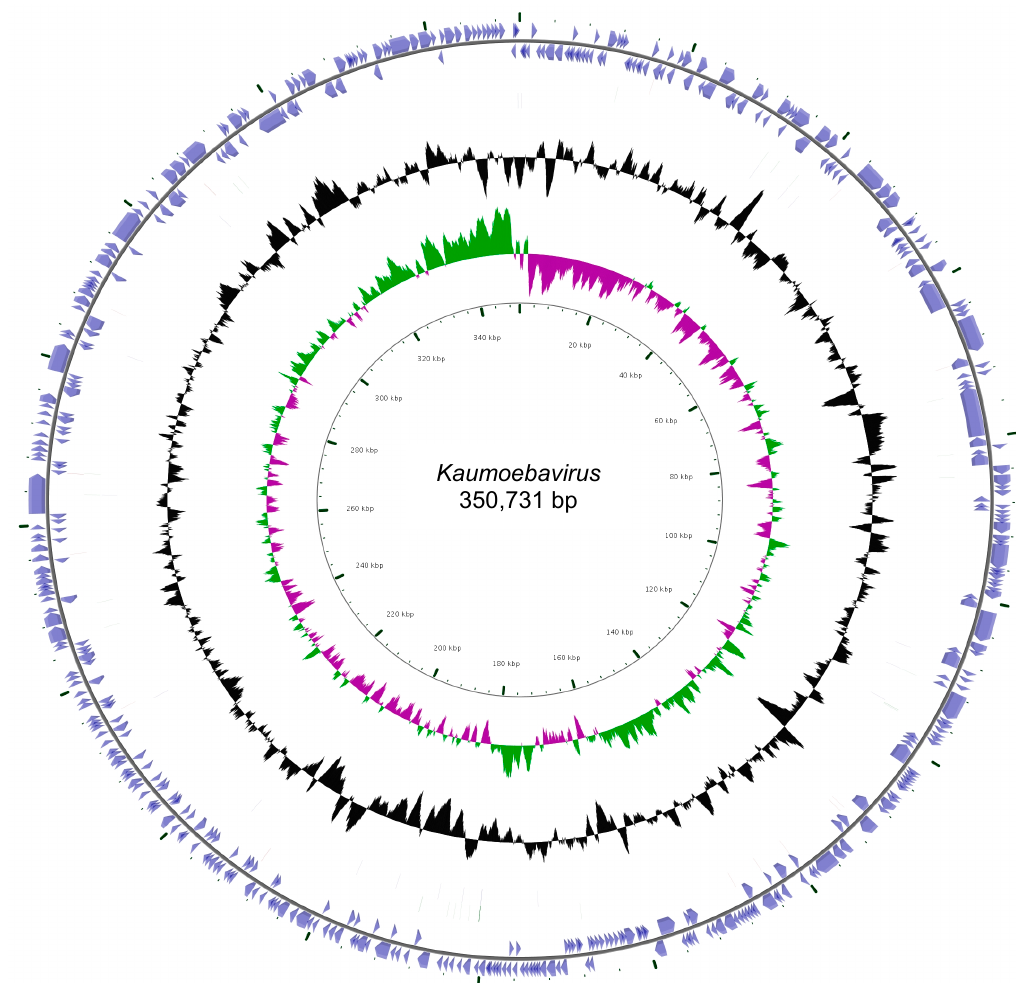
Figure 2. Circular representation of the Kaumoebavirus genome. The circles from the center to the outside show: GC skew (green/purple); GC content (black); open reading frames (ORFs) on the plus and minus strands (blue).